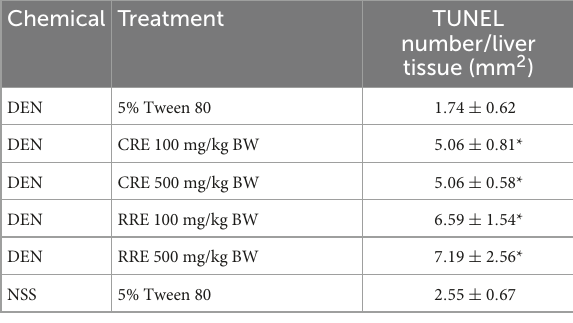
TABLE 4 Effect of cooked glutinous purple rice extracts on apoptotic hepatocytes in DEN-initiated rats. Chemical